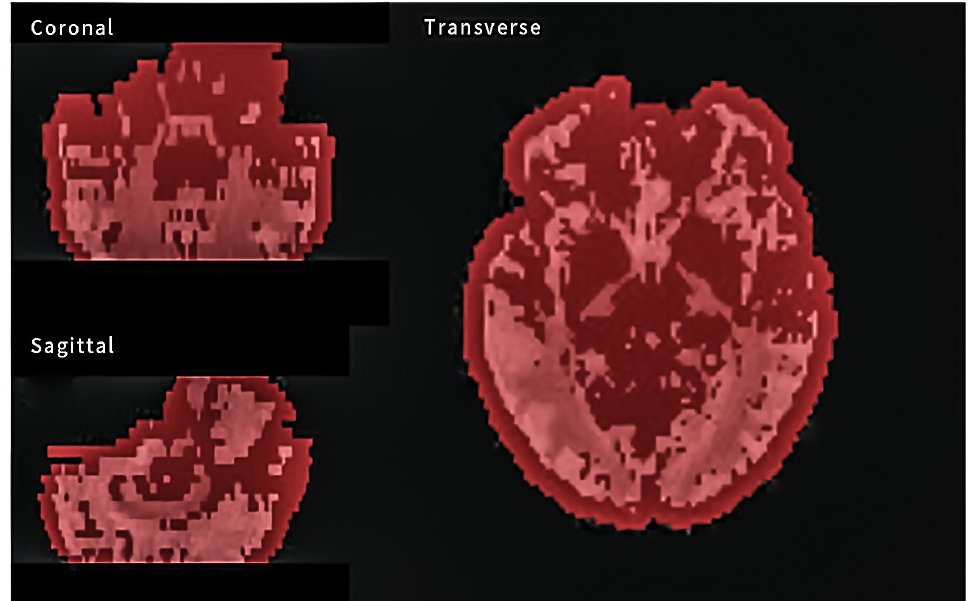
Figure 2. MRI image segmentation feature extraction by Ray-plus software (the whole brain was selected as the ROI for feature extraction in red; grey means FA/MD values).